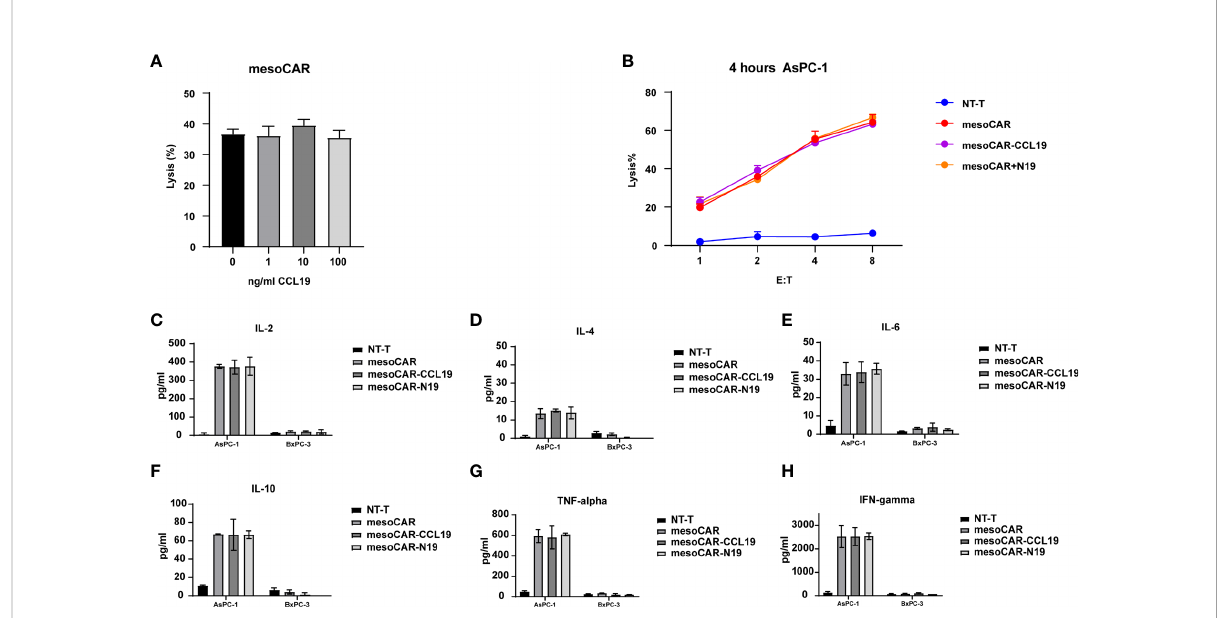
FIGURE 5 Chimeric antigen receptor T (CAR-T) cell activity assays in vitro . (A) Killing activity assay of the mesothelin CAR-T cells with different concentrations of C-C motif chemokine ligand 19 on AsPC-1 cells by LDH assay; (B) Killing activity of CAR-T cells on theAsPC-1 cell line without CCL19; Secretion of (C) interleukin (IL)-2, (D) IL-4, (E) IL-6, (F) IL-10, (G) tumor necrosis factor- a and (H) interferon- g after co-culturing the CAR-T cells with tumor cells, respectively (n =